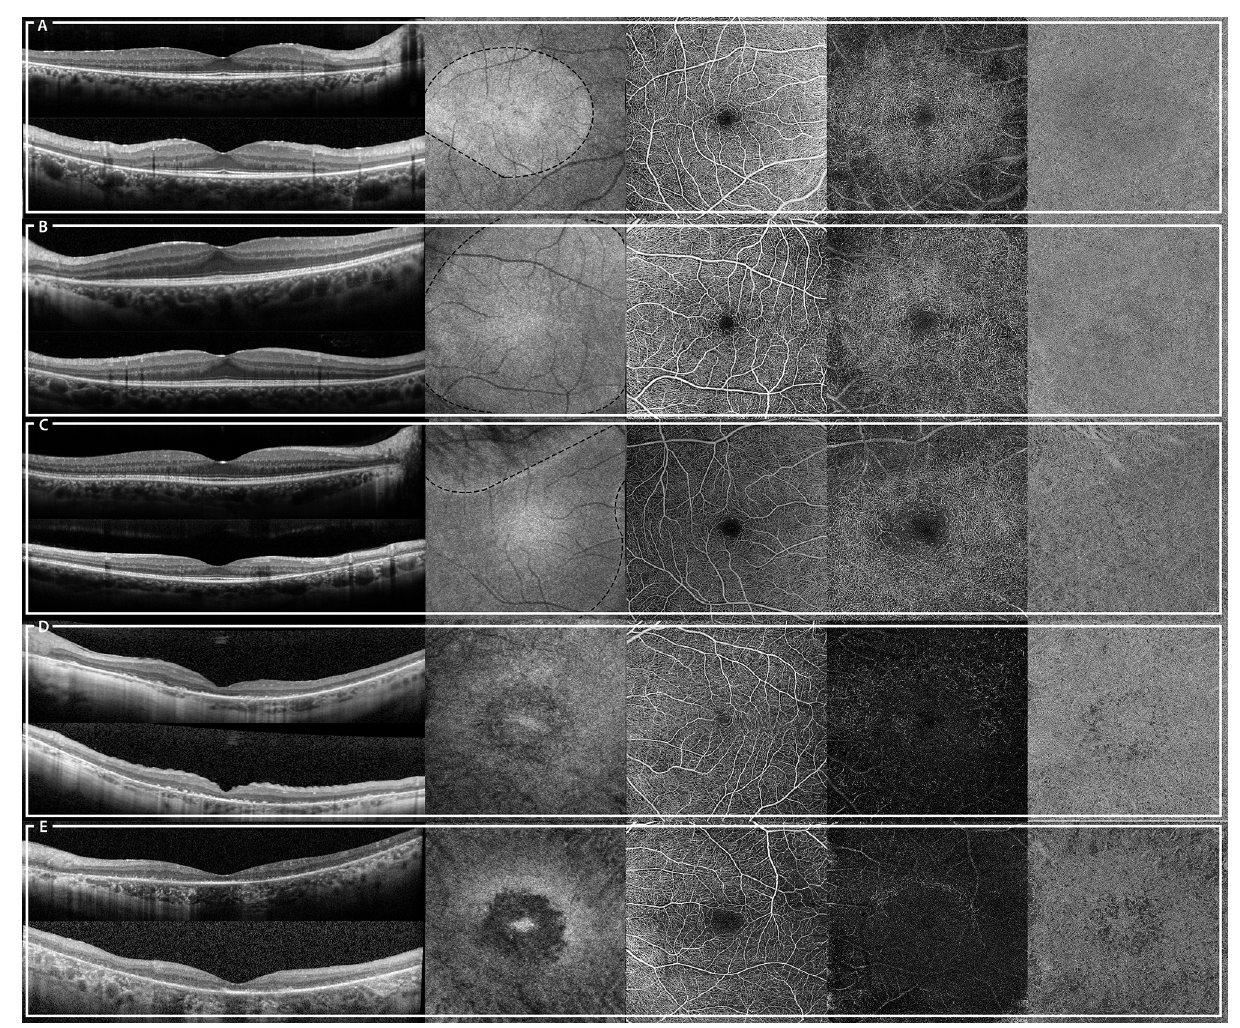
Figure 4. Images from patients with Retinitis Pigmentosa enrolled in the study. From the left to the right, a foveal optical coherence tomography (OCT) horizontal (top) and vertical (bottom) B-scans, a near-infrared fundus autofluorescence (NIR-FAF), the superficial vascular complex (SVC), the deep capillary complex (DCC) and the choriocapillaris (CC) angiograms are displayed. In the NIR-FAF image of ( A – C ), the black dotted lines mark the edge of the area of preserved NIR-FAF. This area is not recognizable in ( D ) and ( E ). Genetic data of displayed patients: CIC10938 ( A ): unknown; CIC12075 ( B ): unknown; CIC04704 ( C ): RHO ; CIC09779 ( D ): RPGR-ORF15; CIC01532 ( E ) :